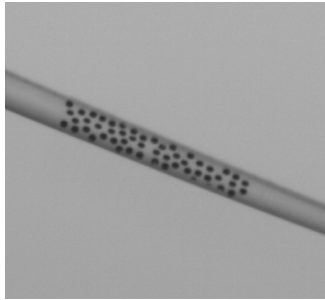
Figure 3. Random speckle pattern for the application of DIC on the blade tips.